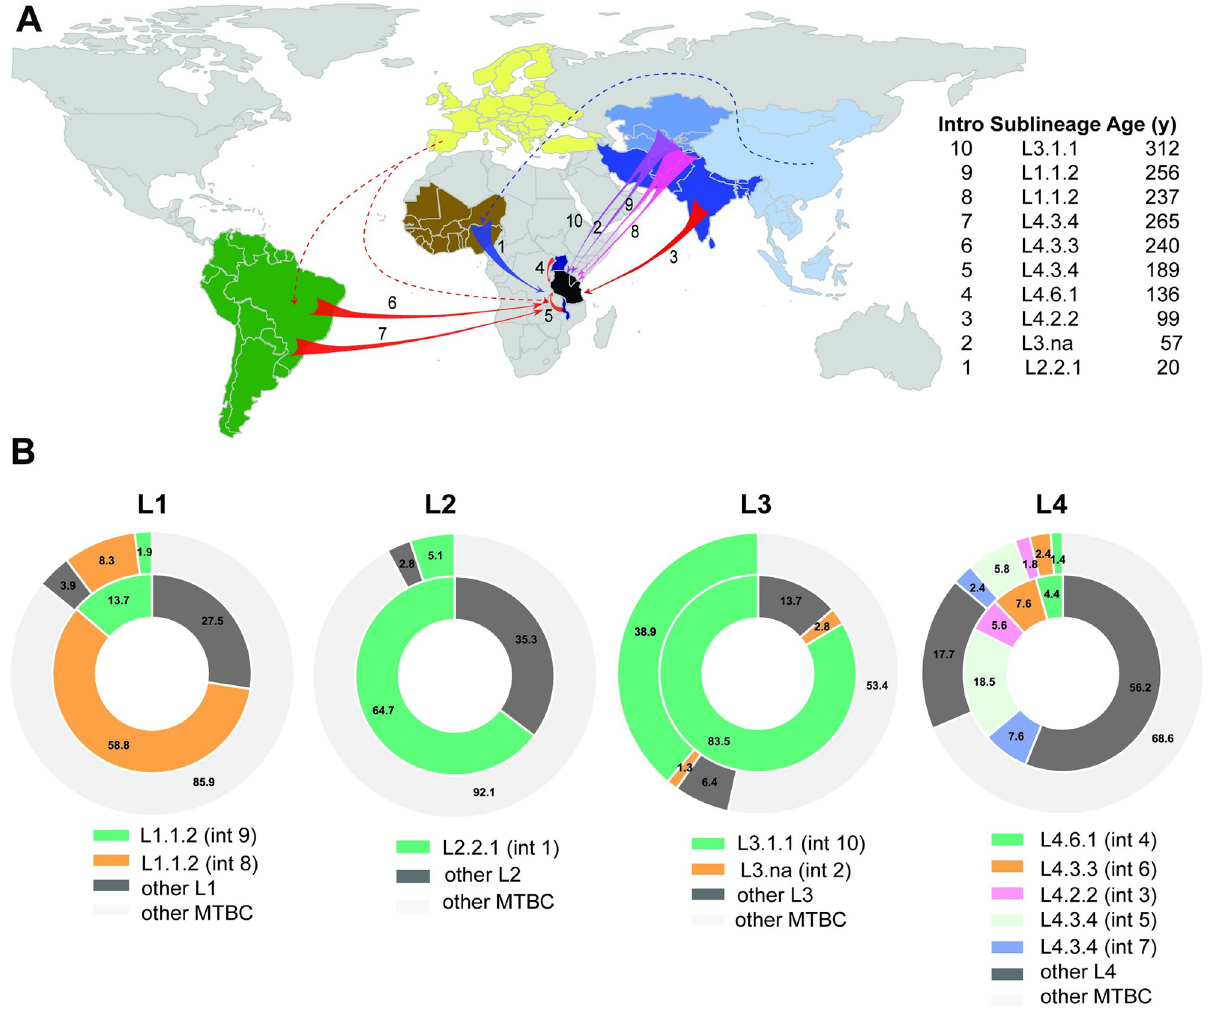
Fig 2. The genotypes in Dar es Salaam resulting from introductions 1–10. A—Geographic origin of the 10 introductions into Tanzania that led to most cases in our cohort. Introductions are labelled as in Fig 1 and are represented by colored arrows according to the lineage. Regions or countries identified as the origin of a successful introduction are colored (dark green: South America; brown: West Africa; dark blue: Malawi and Uganda; black: Tanzania; shades of blue: South, Central and East Asia; yellow: Europe). The age of the introductions were obtained from substitution rates inferred from our dataset except for L1 (See methods and S8 Table for details). The map was created with the R package rworldmap [109] and the shapefile for the map can be found under the following link: https://www.naturalearthdata.com/http//www.naturalearthdata.com/download/110m/cultural/ne_ 110m_admin_0_countries.zip. B—Prevalence of the most prevalent genotypes within each lineage (inner circle) and across all lineages (outer circle).